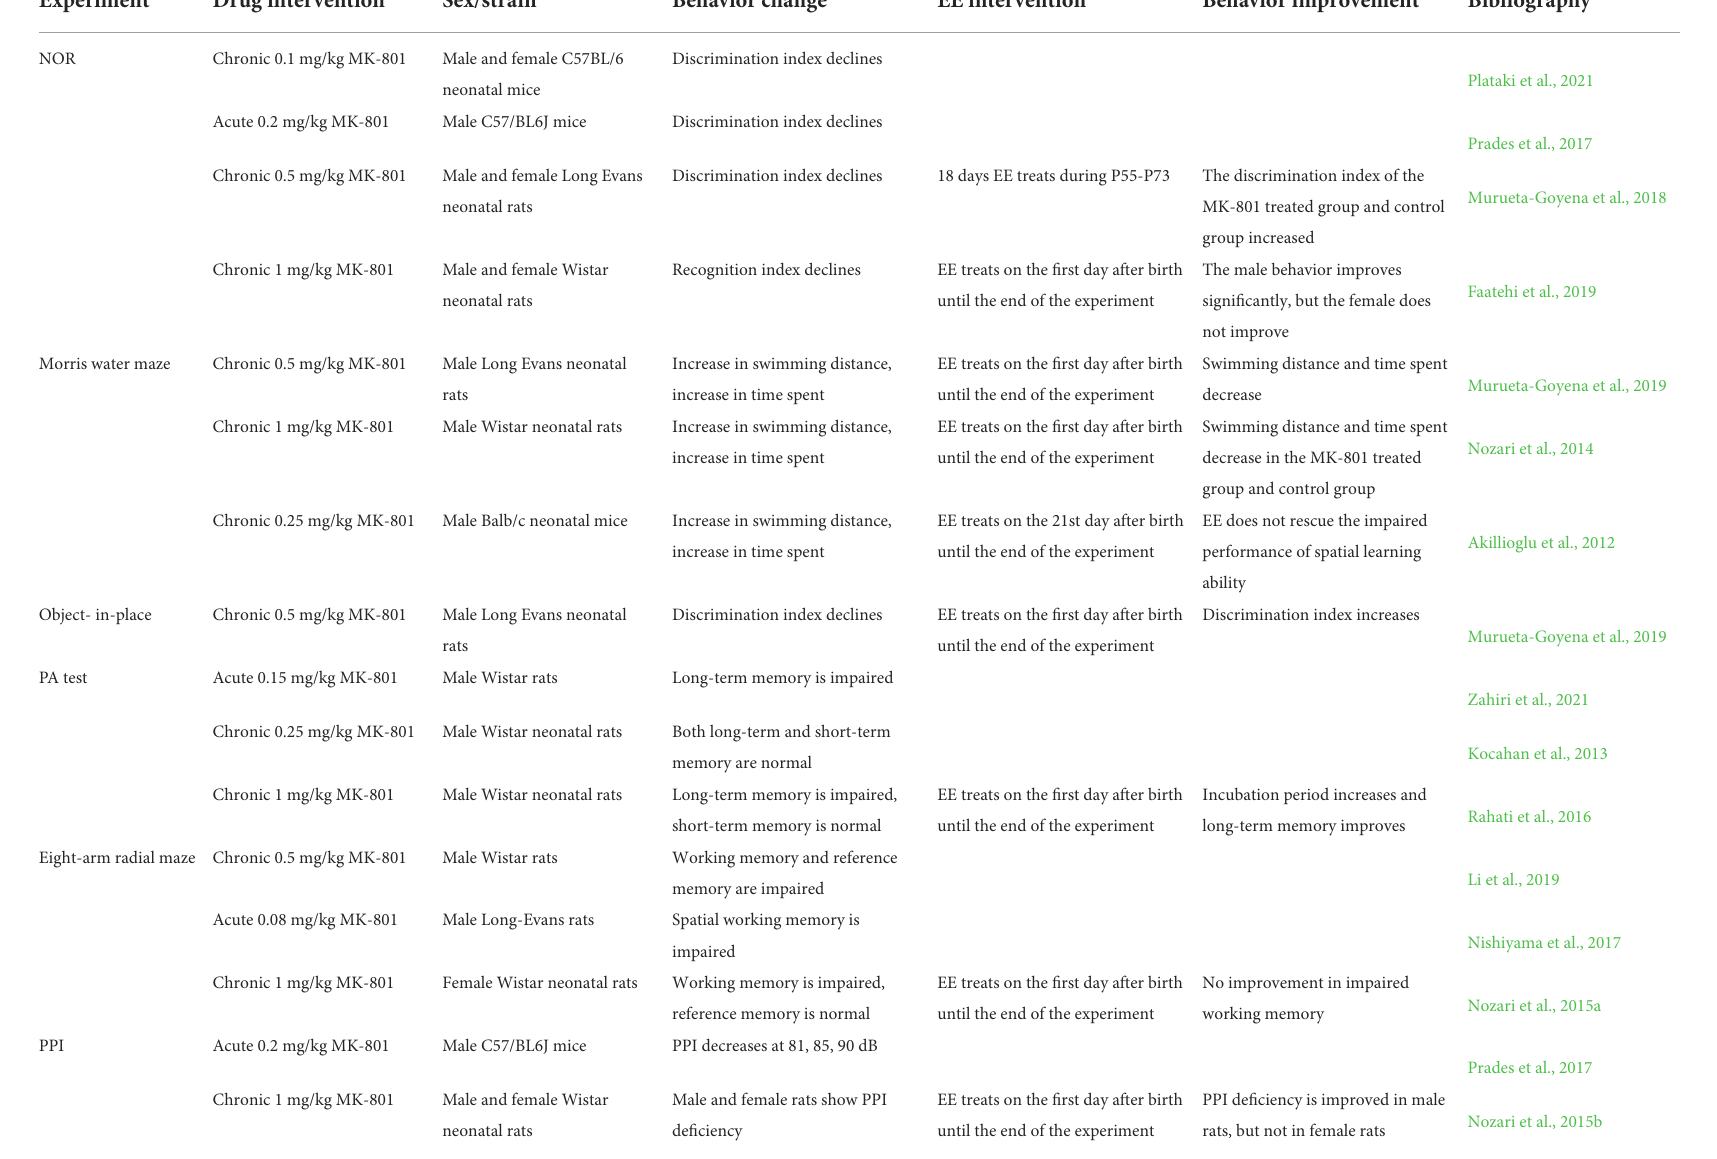
TABLE 1 MK-801 induced cognitive symptoms of schizophrenia in rodents and improvement of cognitive symptoms by